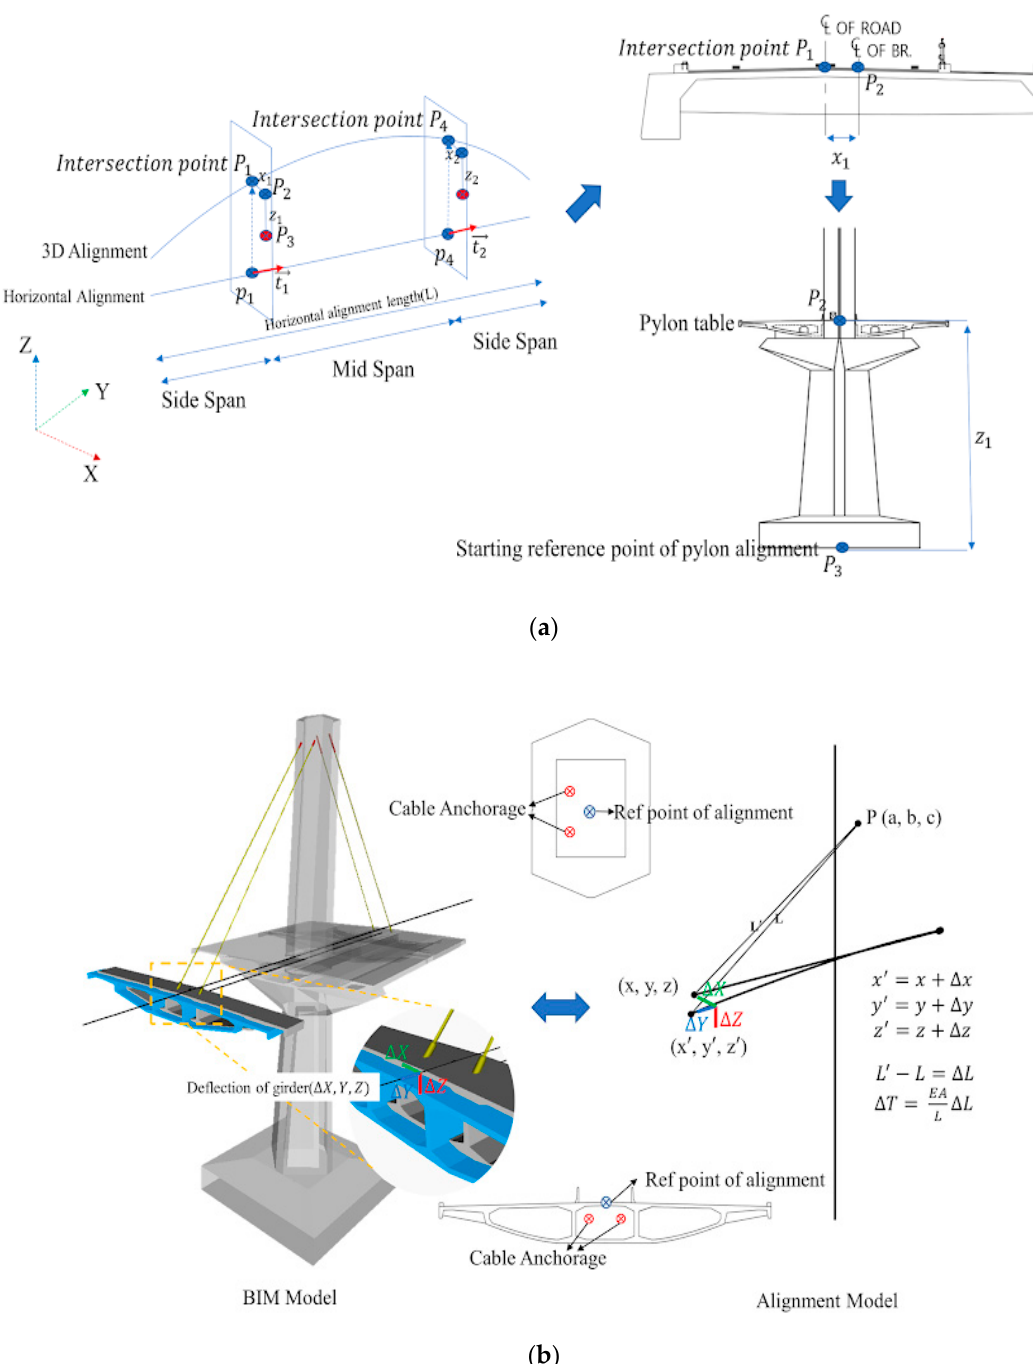
Figure 4. Definition of constraints among members of a cable-stayed bridge: ( a ) constraints between pylon and girder; ( b ) constraints among cable, pylon and girder.